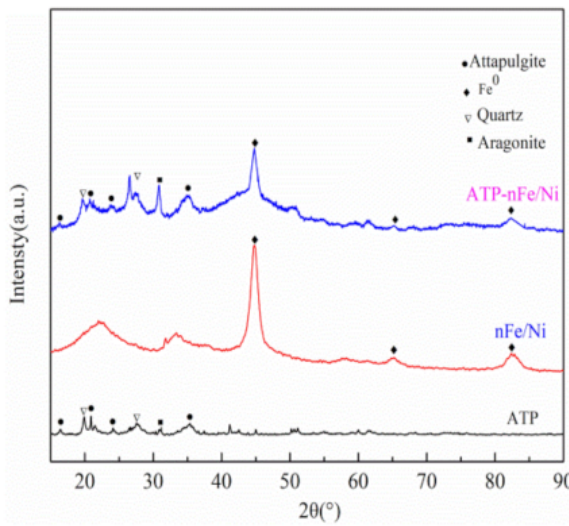
Figure 2. XRD patterns of ATP, nFe/Ni and ATP-nFe/Ni.